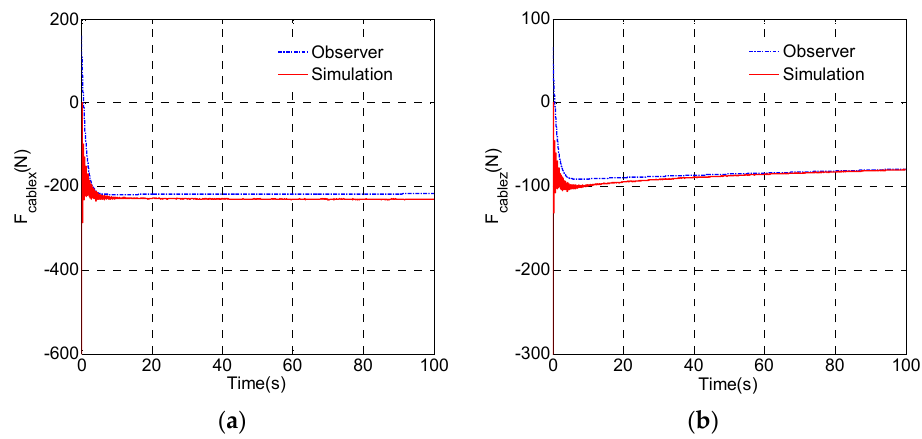
Figure 21. Cable disturbing force (LPM): ( a ) cable force in the X direction; (b) cable force in the Z direction.